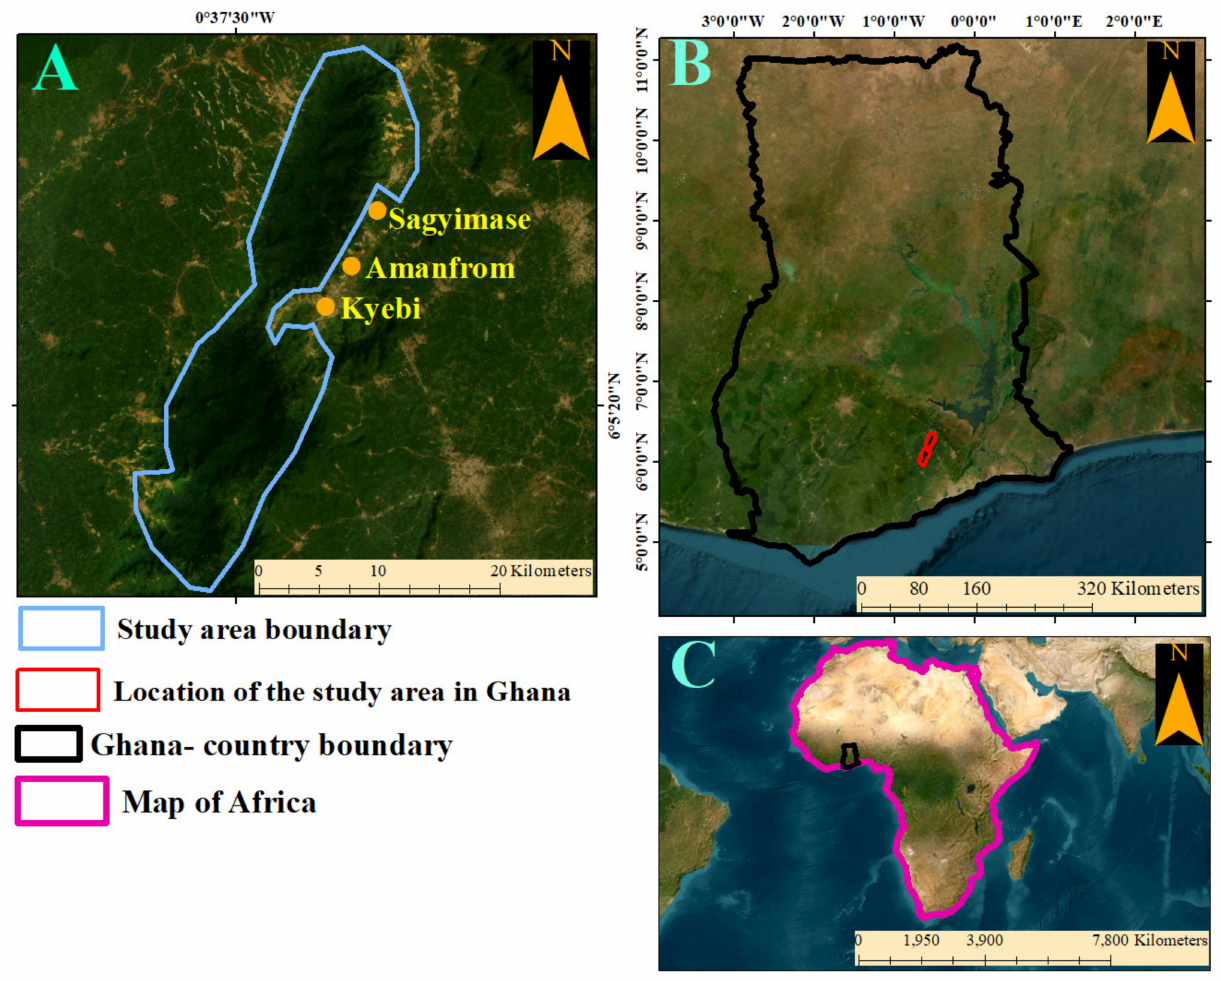
Figure 1. Study area location. ( A ) shows the area covered by the Atewa Range Forest Reserve, ( B ) shows the study area in the context of Ghana, and ( C ) shows Ghana in the context of Africa. Whereas the protected status has been able to reduce forest degradation to some extent, the rate of degradation has been faster over the past few decades. For instance, Meijer et al. [20] have noted that the closed-canopy forest cover reduced from 88% in 1990 to 60% in 2010. Similarly, the closed-canopy forest cover formed about 91% of the total reserve area but decreased to about 81% in 2010. Most of the closed-canopy forest